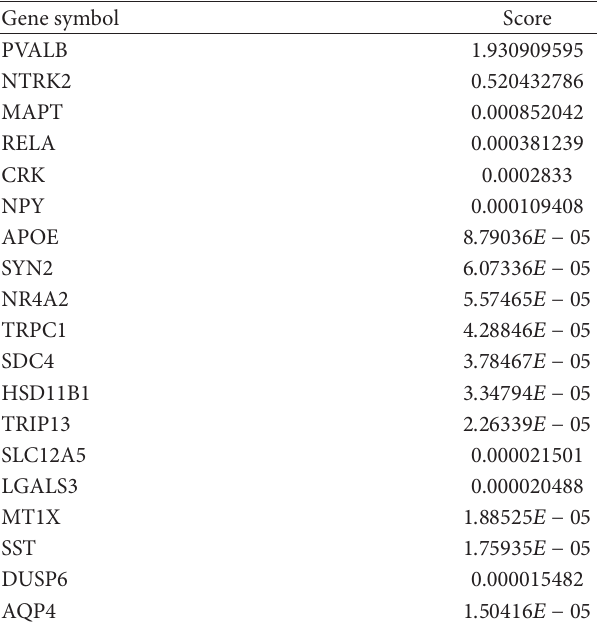
T 12: Prioritization of the genes presented in table 12, by Bio- Graph exploiting unsupervised methodologies for the identi�cation of causative BD-associated genes. Genes with the higher nineteen scores are